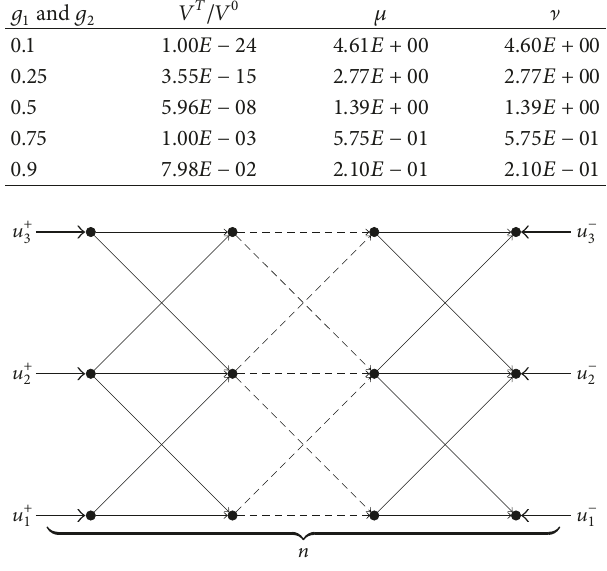
Figure 2: Cascade network with 𝑛 layers and six controls 𝑢 ± 𝑠 , 𝑠 = 1, 2,3